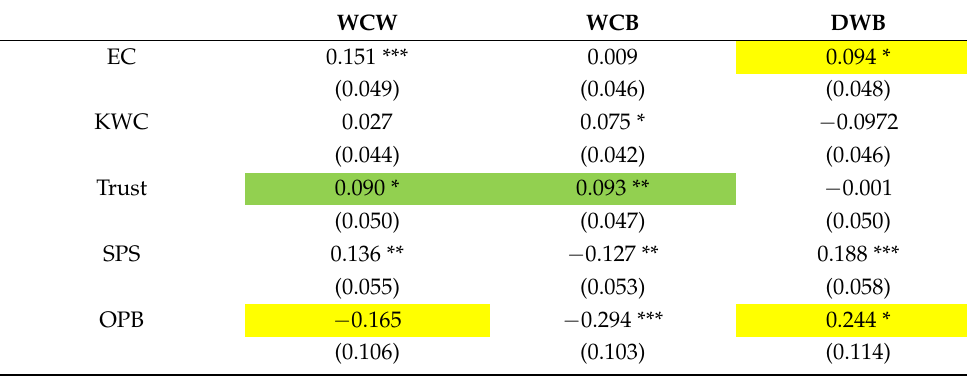
Table 5. The empirical results of ordered probit